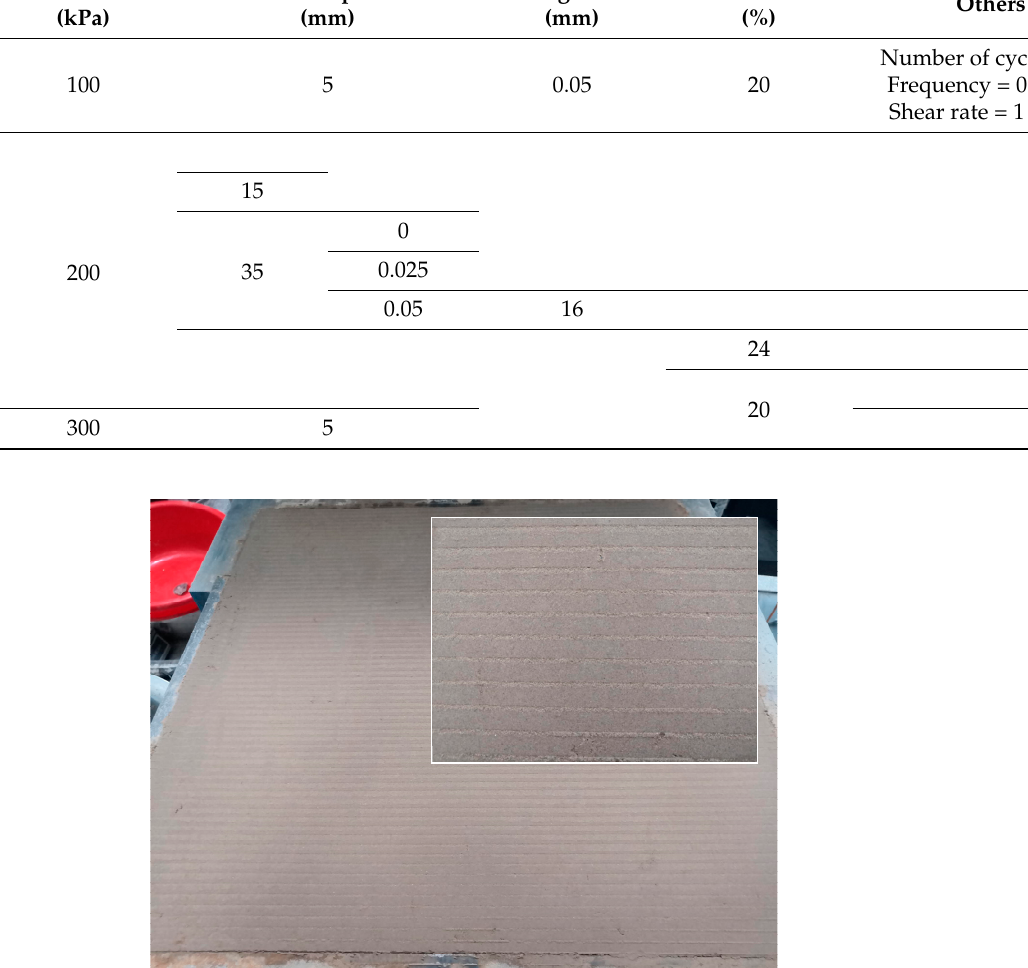
Figure 7. Shear interface after the test was completed.